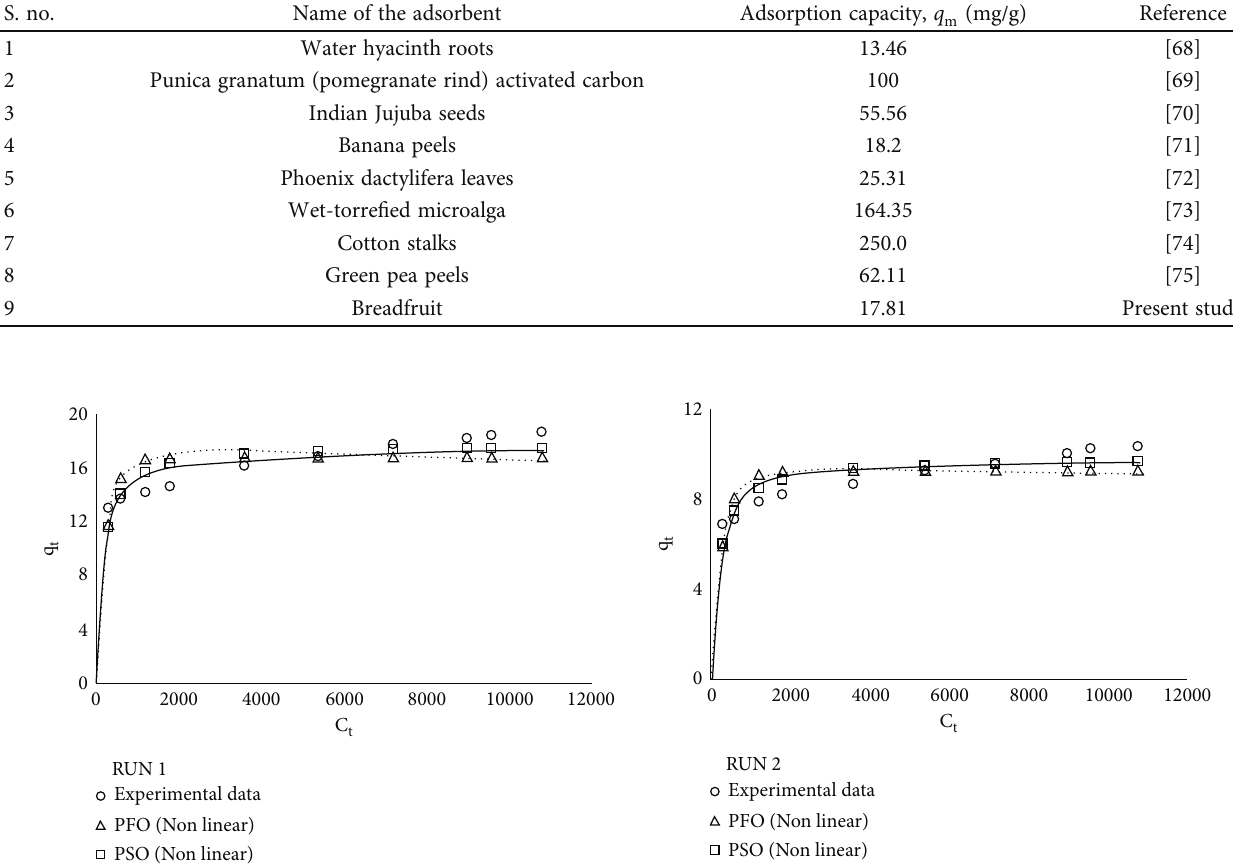
Figure 6: Nonlinear plots of PFO and PSO kinetic models for the adsorption of Congo red dye on breadfruit leaf